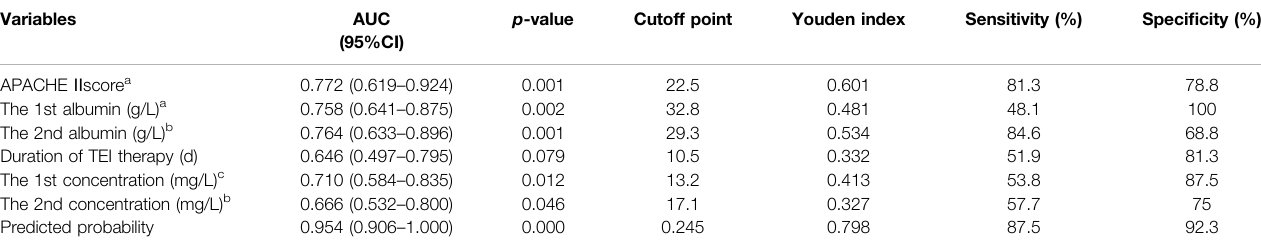
TABLE 5 | Area under the curve and cutoff values of receiver operating characteristic curve for predicting effects on clearance of Gram-positive bacteria. p -value Cutoff point Youden index Variables AUC (95%CI) APACHE Ⅱ score a 0.772 (0.619 – 0.924) 0.001